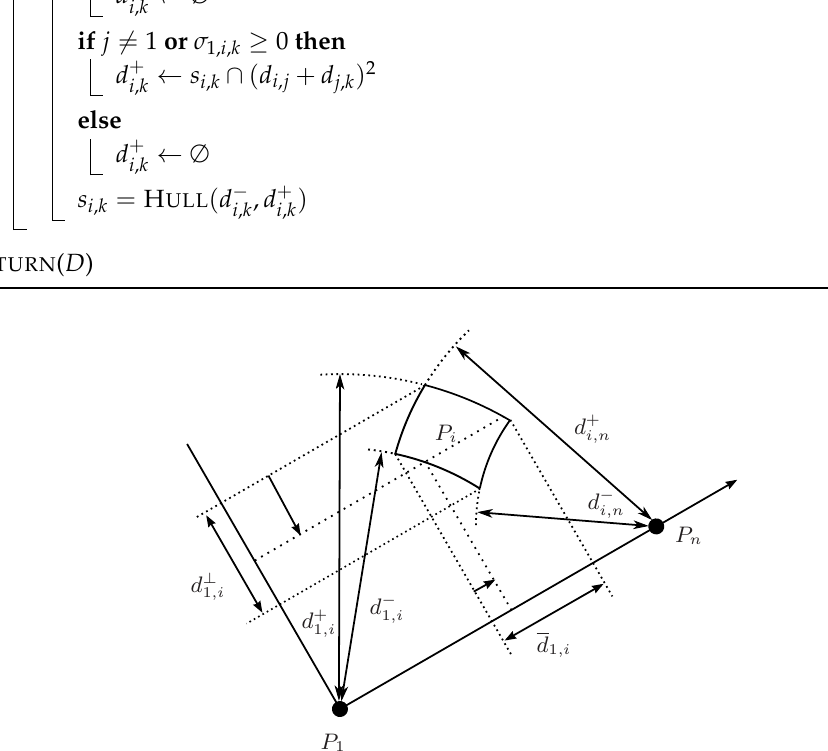
. A reduction in the range of 1, i